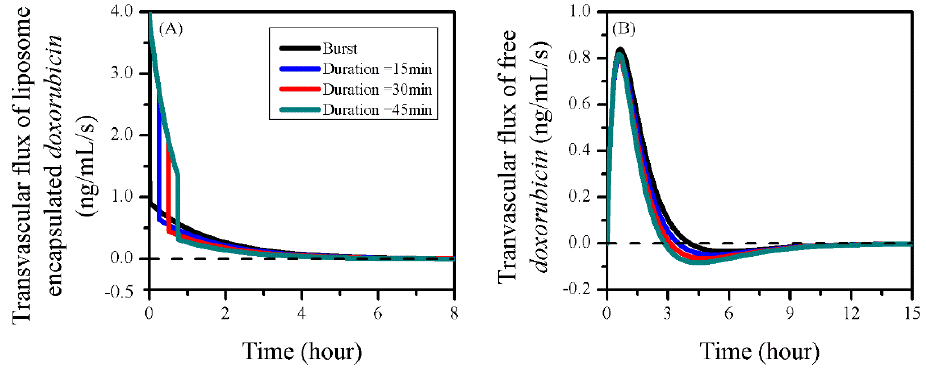
Figure 13. The time courses of drug transvascular flux in the treatments with different sonication durations. ( A ) Liposome-encapsulated doxorubicin and ( B ) free doxorubicin.